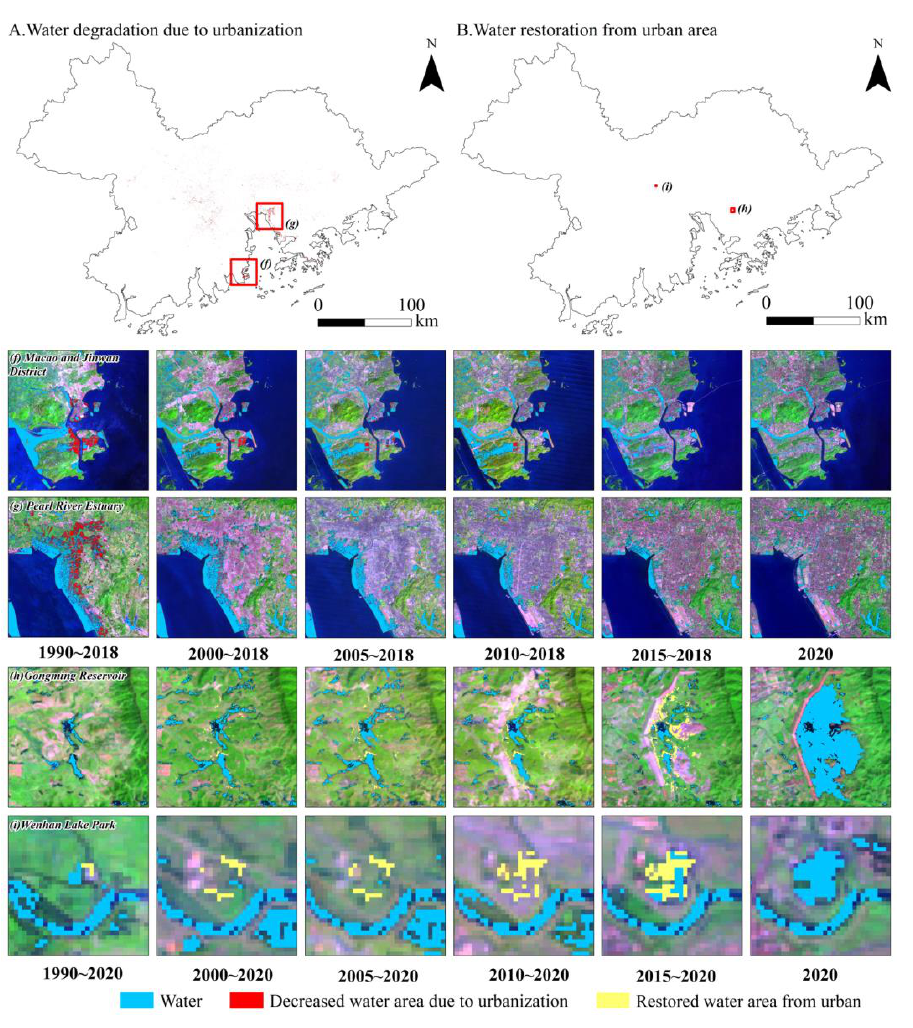
Figure 11. Decreased and restored surface water area caused by urbanization. The upper two rows ( f , g ) represent the decreased surface water during five periods: 1990~2018, 2000~2018, 2005~2018, 2010~2018 and 2015~2018. The two rows ( h , i ) at the bottom represent the restored surface water during five periods: 1990~2020, 2000~2020, 2005~2020, 2010~2020 and 2015~2020. The blue area is the surface water in the starting year during the respective periods. (The background image is the median composite of Landsat images with RGB channels: Red: SWIR, Green: NIR, Blue: Green.). Through the land cover confusion transfer matrix, the area of water bodies trans- formed into impervious surfaces and the area of built-up areas transformed into water bodies in different years were calculated(Figure 12). The surface water losses area shows a significant declining trend from 211.29 km 2 in 1986 to 2.92 km 2 in 2015 (Figure 12(a)),